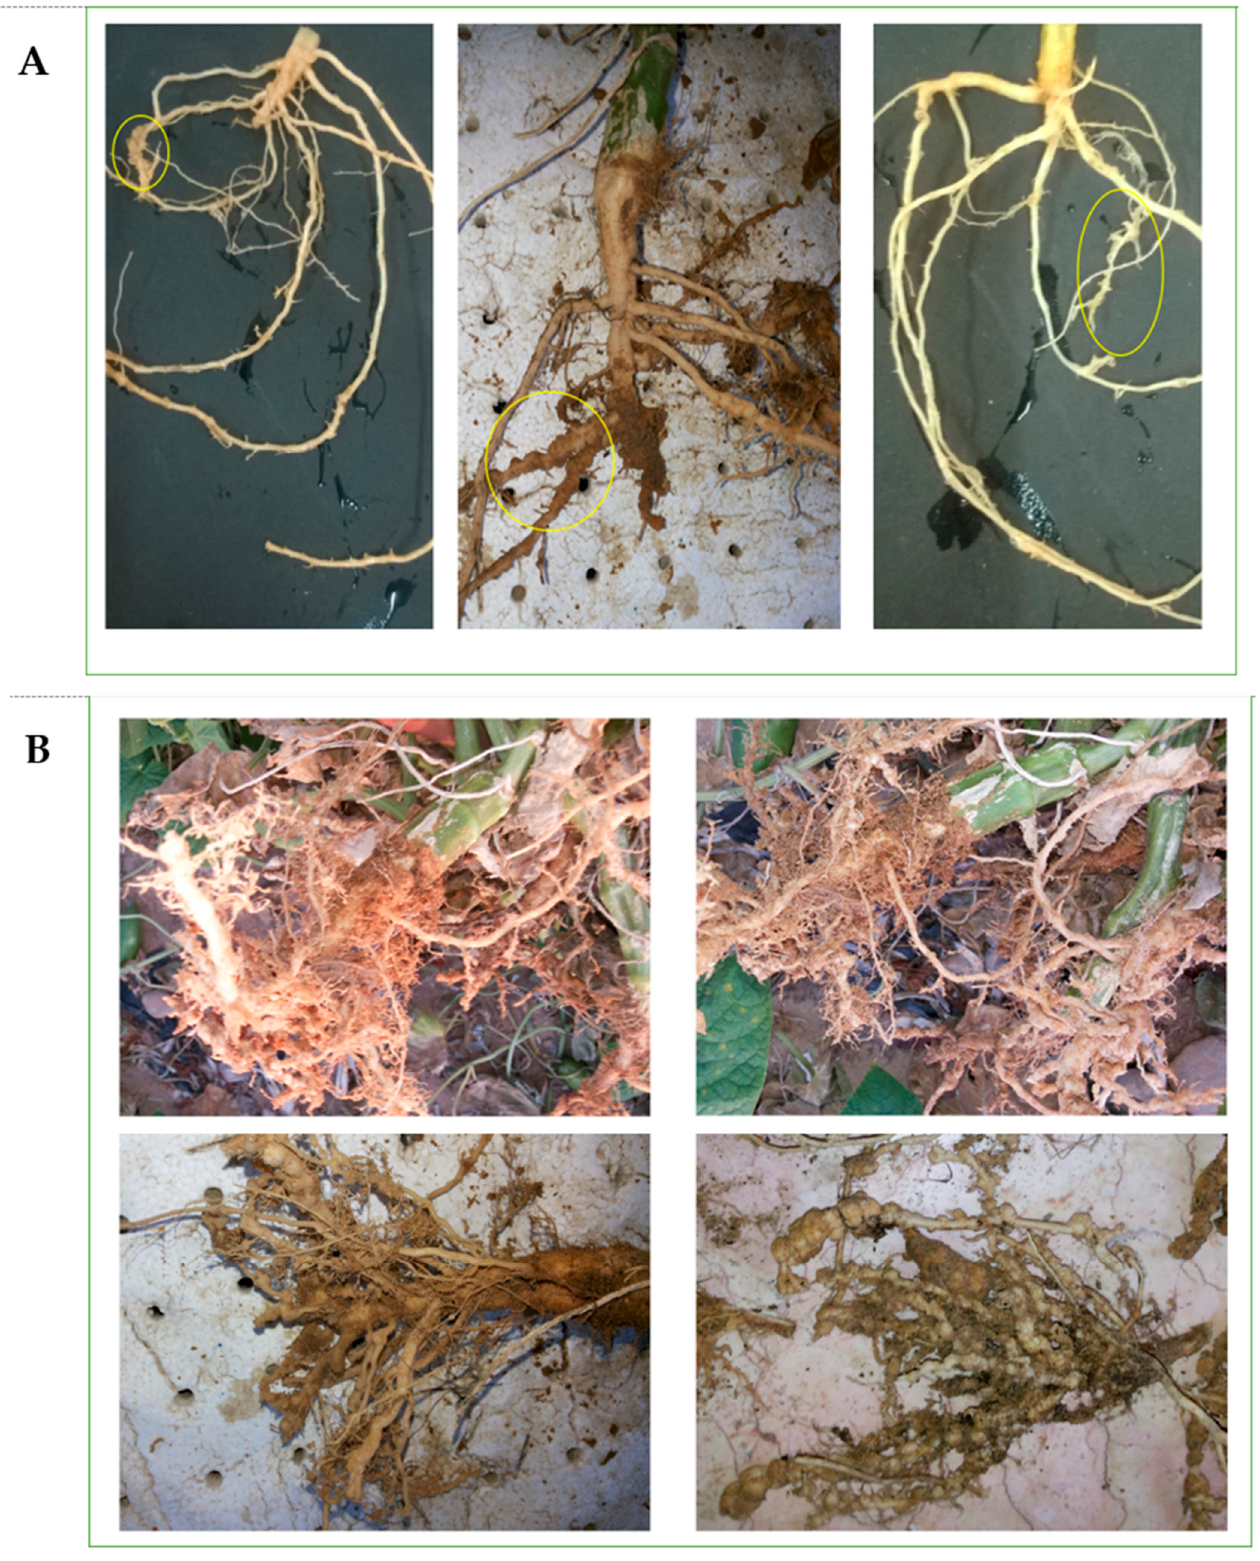
Figure 6. The effects of the incorporation of broccoli plantlets treatment on cucumber root systems ( A ) and the cucumber root systems in control treatment ( B ).